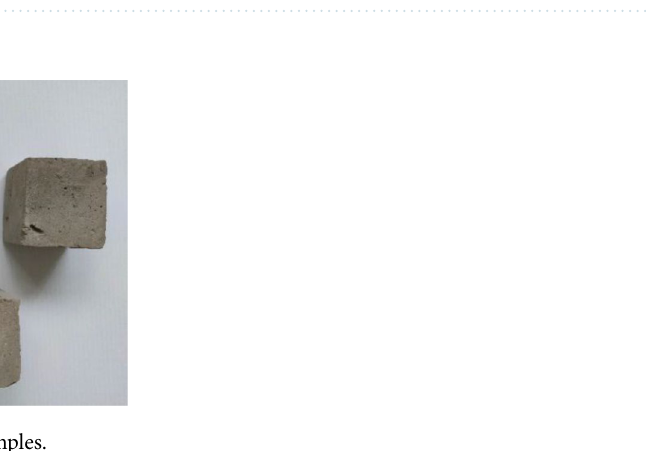
Figure 9. State of dry saturated samples.